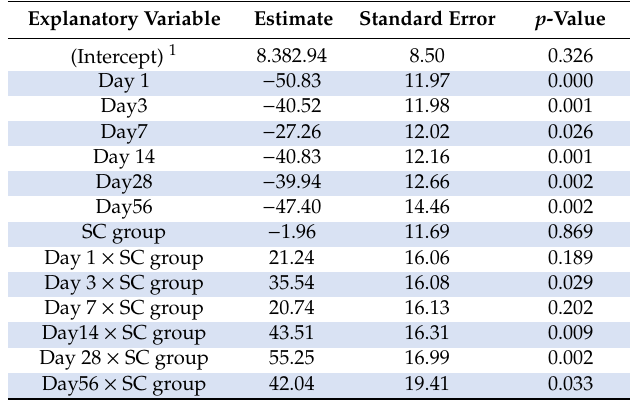
Table 6. Estimates and standard errors for intercept and di ff erences with reference category Vertical Impulse (VI) for each explanatory variable in the final